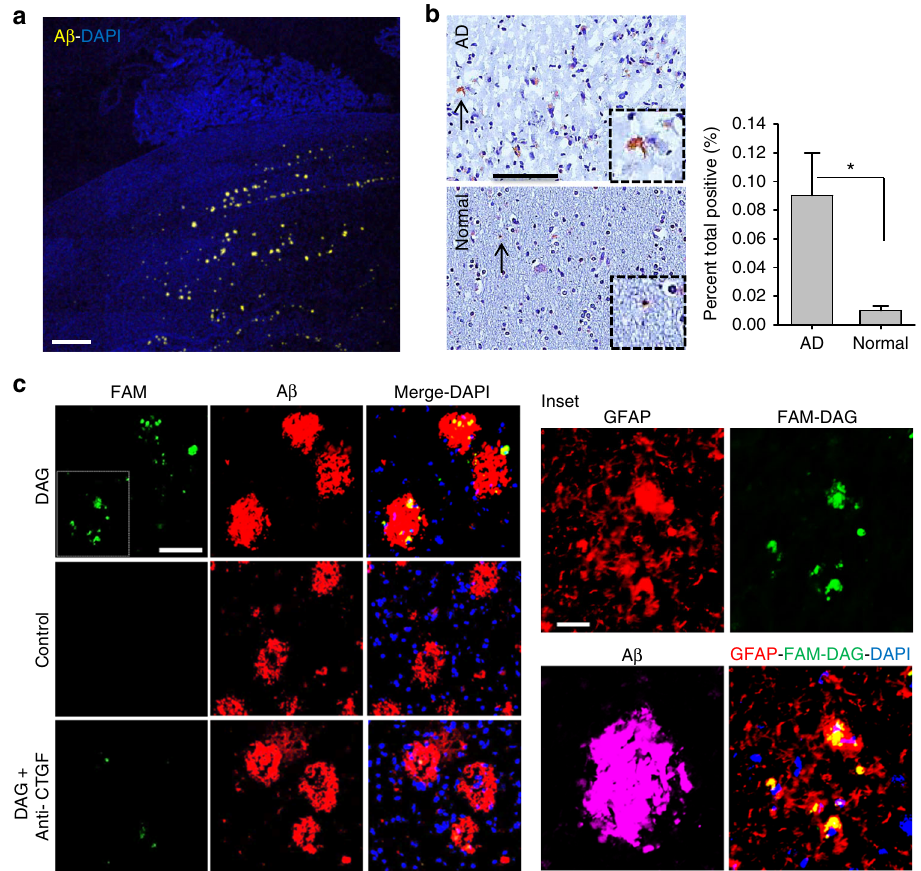
Fig. 5 A β and CTGF expression in human brain, and DAG binding to human AD brain sections. a Sections from an AD patient brain were stained for A β ( yellow ) and counterstained with DAPI. Scale bar , 1 mm b Representative immunohistochemistry images of CTGF in brain sections of an AD patient and a control individual. The signal was quanti fi ed and plotted ( bar diagram ). Scale bar , 100 µ m. * P < 0.05. c Human AD brain sections were incubated with either FAM-DAG ( top row ), control peptide ( middle row ) or anti-CTGF followed by FAM-DAG ( bottom row ), and stained for A β ( red ). Sections were counterstained with DAPI. Green signal is from native FAM fl uorescence from peptide. Scale bar , 50 µ m. Inset shows higher magni fi cation of boxed area from panel c co-stained with GFAP antibody ( red ). Scale bar , 20 µ